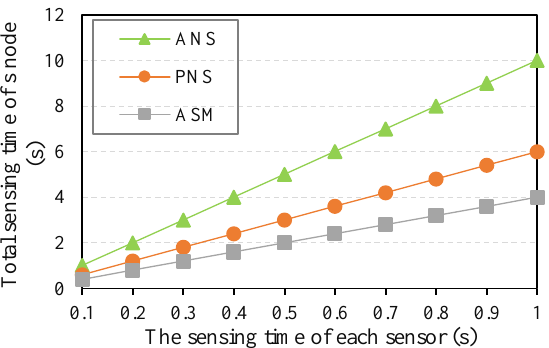
Figure 5. The results of sensing time in different methods. The results of data collection time, including sensing time and data transmission time, for completing data collection under different communication rates in the network cluster are presented in Figure 6. As shown in Figure 6, with the continuous increase in the communication rate, the data collection time corresponding to the three schemes generally presented a downward trend. In other words, the higher the communication rate was, the shorter the data collection time was. Under the communication rate range of 100–300 b/s, the falling range (the Max collection time to the Min collection time) of the ANS was the largest, followed by those of the PNS and ASM, which was due to the small proportion of number sensing time under these conditions. Furthermore, the ASM selected nodes and sensors that were aware of the correlation analysis degree and optimized the